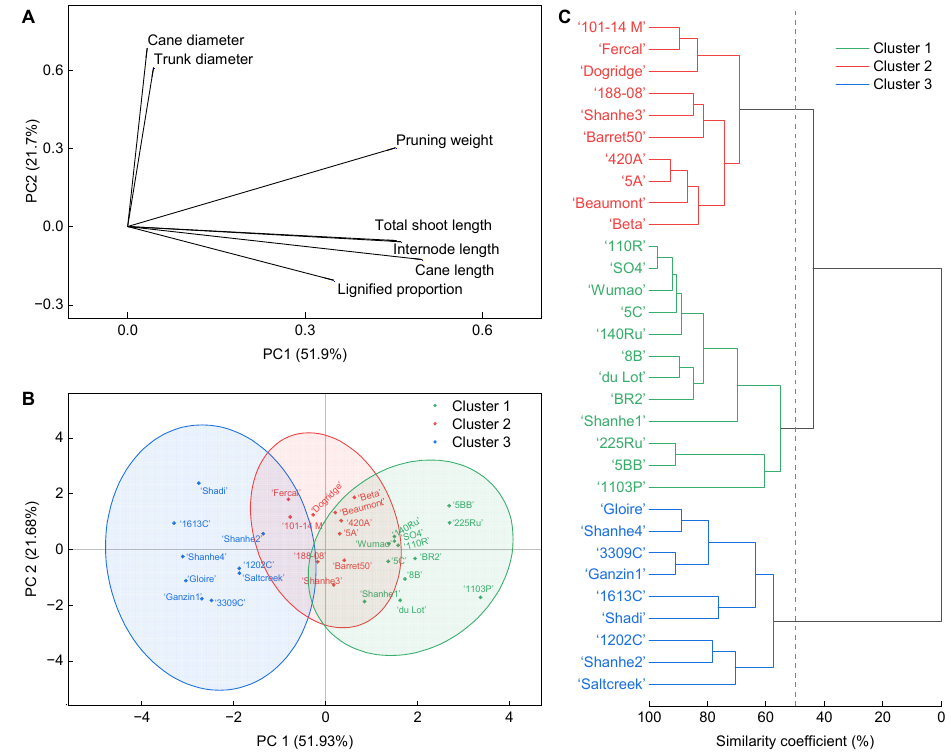
Figure 4. Principal component (PC) analysis of seven vigor-related variables for 31 grapevine rootstocks and hierarchical clustering (HC): ( A ) PC loading plot; ( B ) score plot; ( C ) dendrogram based on seven PCs. A confidence ellipse (95%) is drawn on each cluster on the score plot in a corresponding color. Calculated scores obtained by multiplying factor scores by eigenvalues were sub- jected to hierarchical cluster analysis (HCA). The average linkage method and Euclidian distance were used to separate the rootstocks. The dendrogram was separated into three clusters at 50% similarity, and Clusters 1, 2, and 3 consisted of 12, 10, and 9 varieties, re-